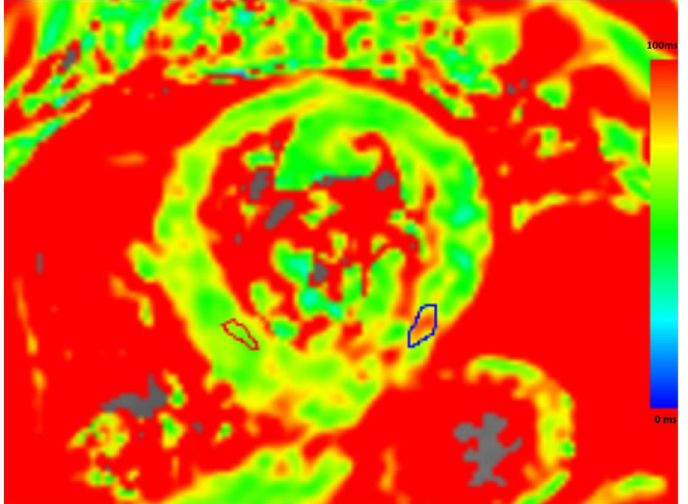
Figure 4. T2 mapping: prolonged myocardial relaxation inferolateral basal segment of the left ventricle up to 62–64 msec.